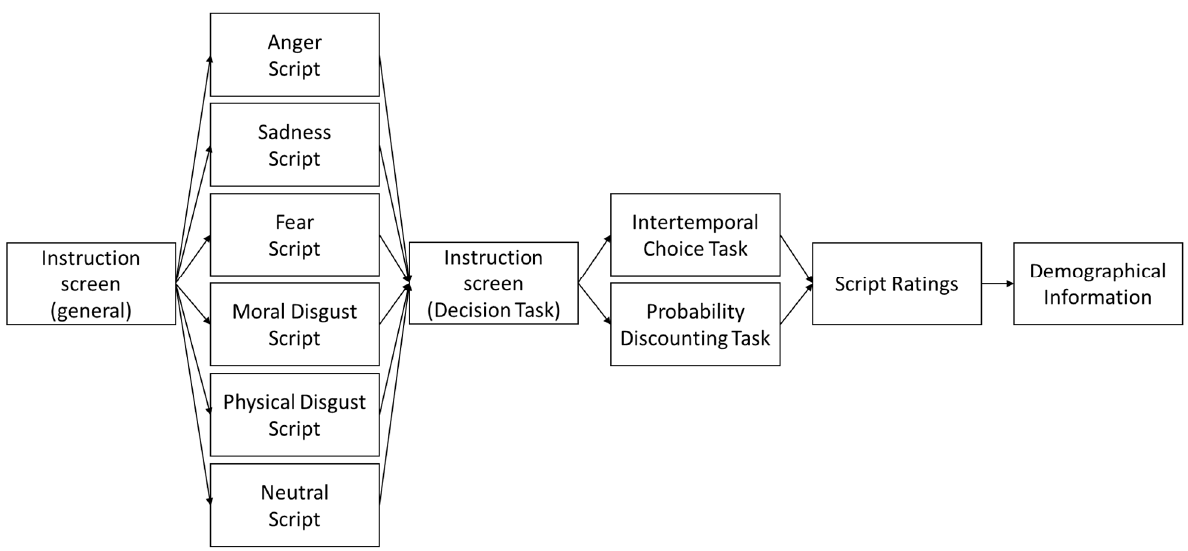
Figure 1. Experimental Procedure of Experiment 1 and Experiment 2. Participants were given some general information with respect to the structure of the experiment, then they were asked to read one of the six possible scenarios (randomly assigned). In the next phase, before taking part in the decision task, participants received the instruction (i.e., ITC in Experiment 1 and PD in Experiment 2). Finally, participants were asked to evaluate the story they read at the beginning of the experiment, according to the different emotions (i.e., anger, fear, sadness, moral and physical disgust), and were asked to provide some demographical